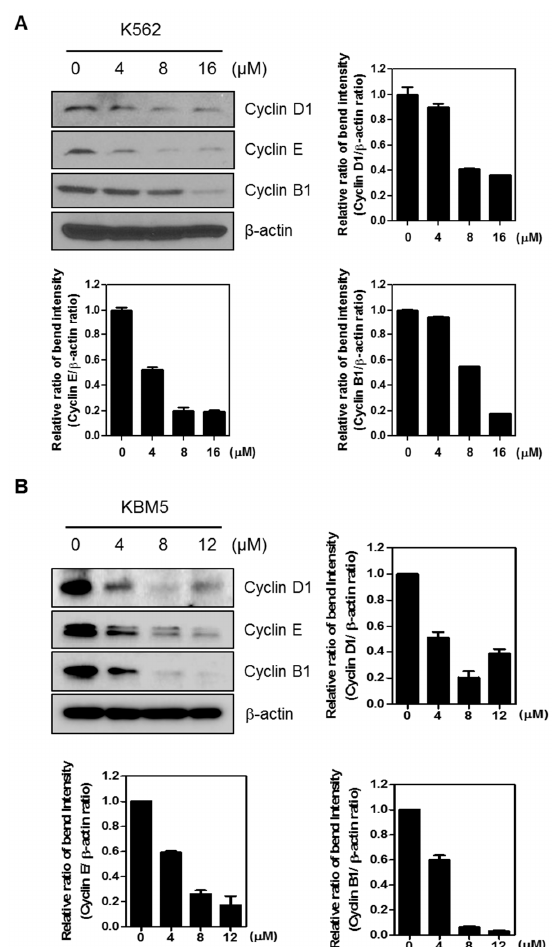
Figure 3. FC regulates cell cycle related proteins in ( A ) K562 and ( B ) KBM5 cells. K562 and KBM5 cells were treated with FC (4, 8, or 16 µM) for 24 h. Cell extracts were prepared and subjected to Western blotting with Cyclin D1, E, and B1 antibodies. β -actin was used as an internal control.